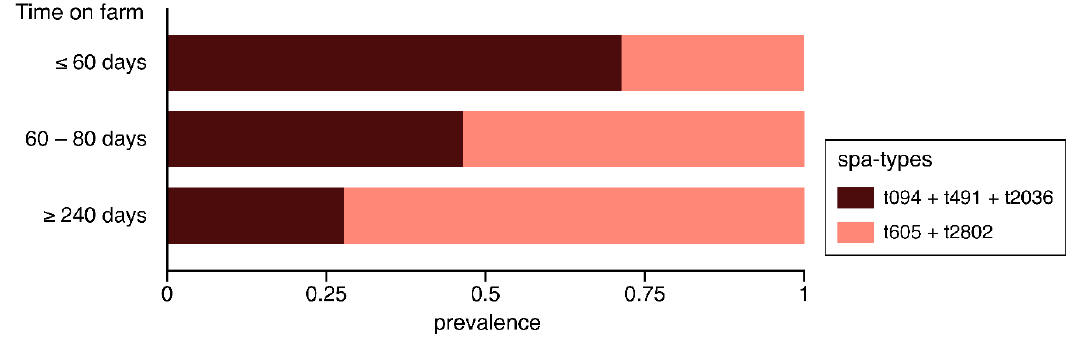
Figure 5. Prevalence of significantly more resistant spa types (t605 and t2802) against the less resistant ones for each in-farm time category. Table 5. Predicted counts of resistance by the clusters and time on farm of the categories. Estimated Resistance Cluster Time on Farm (Days) Estimated 95% (No.)